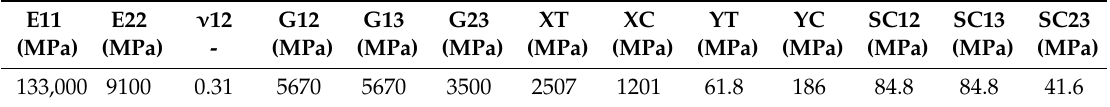
Table 1. Mechanical properties of T700/5429.